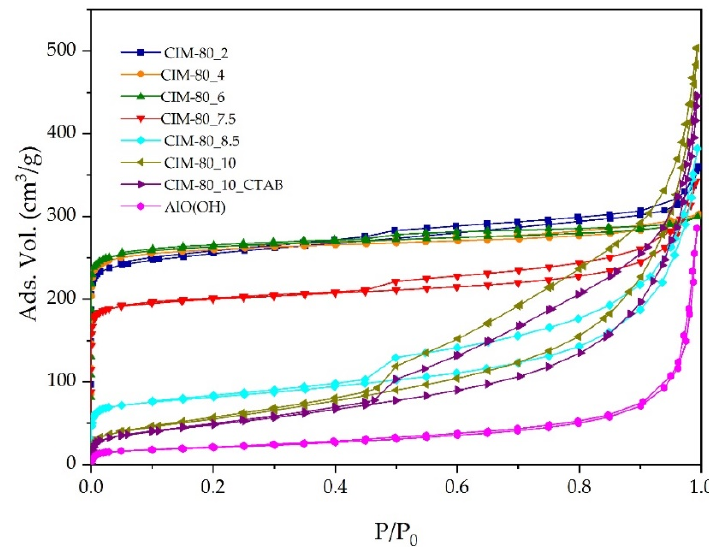
Figure 3. N ₂ adsorption isotherms for the synthesized materials. Figure 3. N 2 adsorption isotherms for the synthesized